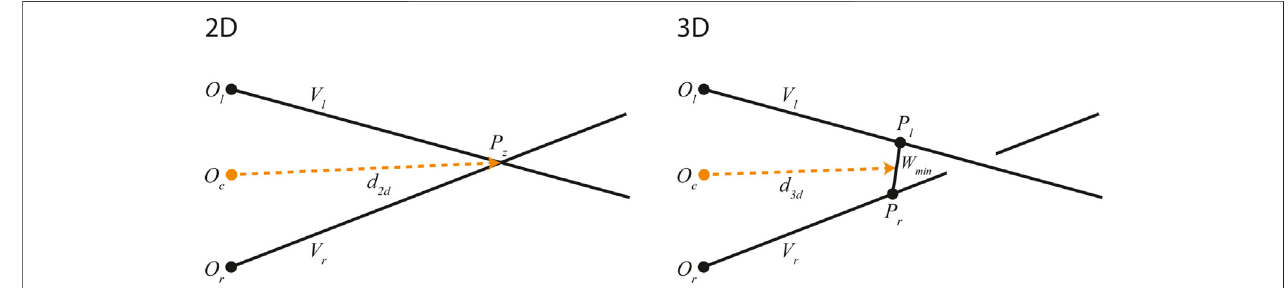
FIGURE4 | 2D (left) and 3D (right) methods for estimating vergence depth. O l , O r , and O c represents the left, right and center eye-gazeorigins, respectively. V l and V r aretheeye-gazevectorswhile P l and P r representspointsalongeachvector. W min isthevectorwiththeminimum P l to P r distance,while P z representsthepointwhere the two eye-gaze vectors intersects along in horizontal (2D) plane. d 2 D and d 3 D represents the estimated vergence depth, using the 2D and 3D methods, respectively.